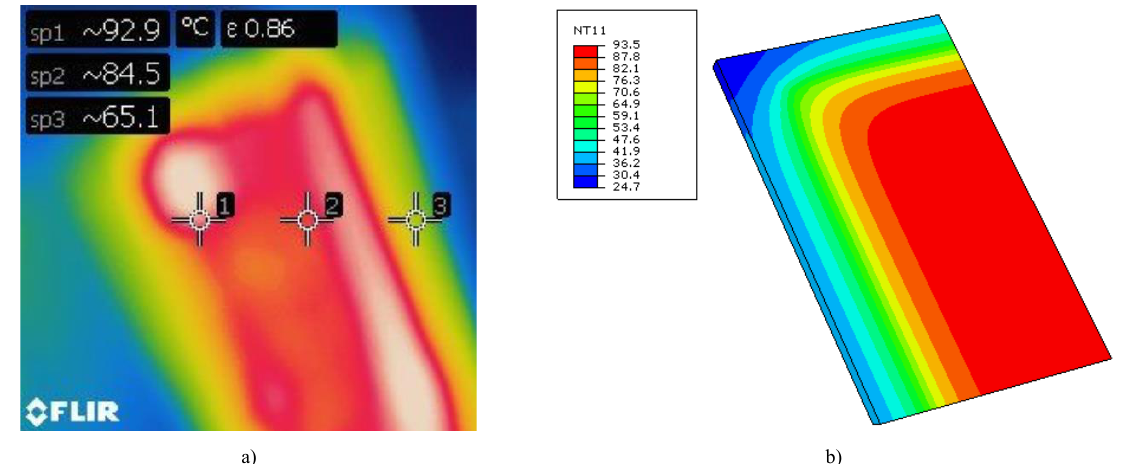
Fig. 6 Small-scale CLT-glass analysis: a) example of the typical thermal camera acquisition (glass in evidence) and b) corresponding FE estimation (with CLT frame and mesh pattern hidden from view; temperature values in